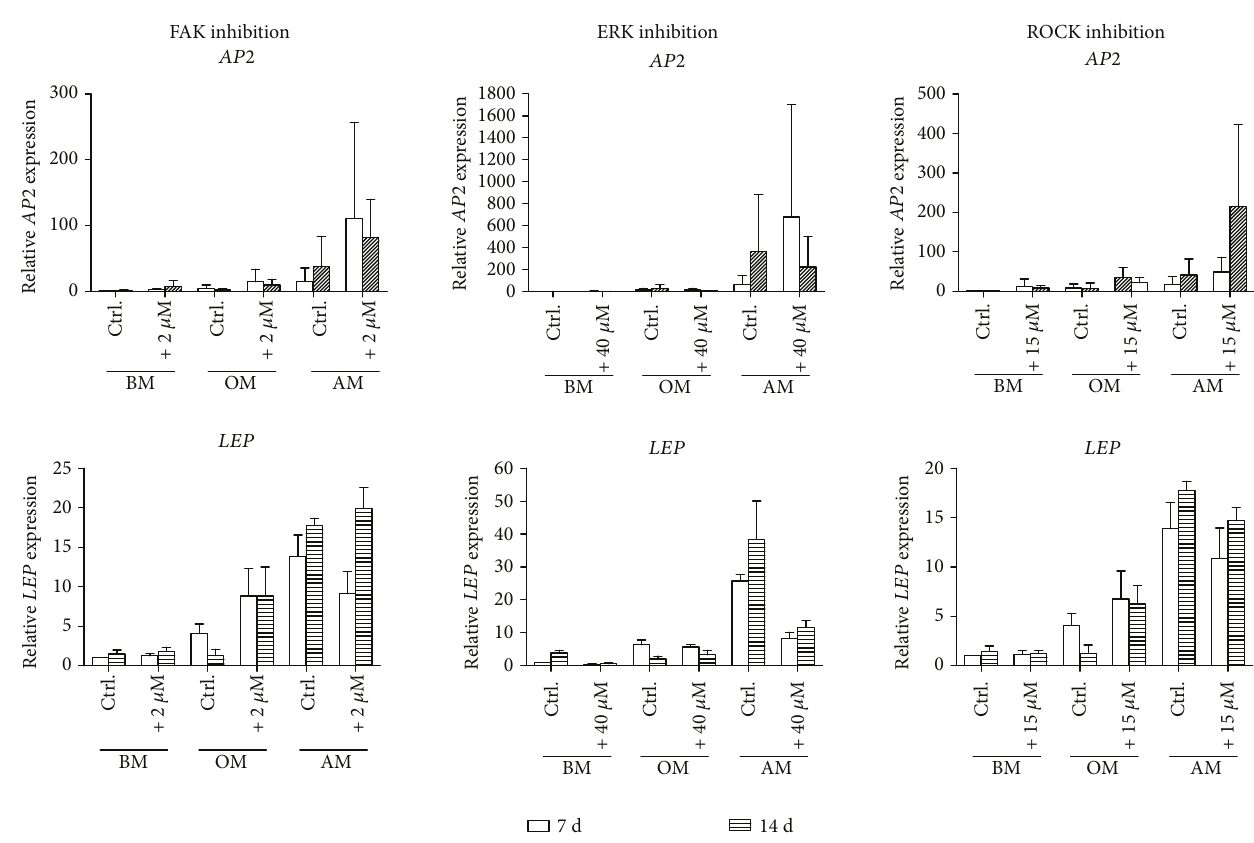
Figure 4: Expression of adipogenic marker genes AP2 and LEP in hASCs treated with FAK, ERK, and ROCK inhibitors. The hASCs were cultured in BM, OM, or AM supplemented with 2 μ M FAK, 40 μ M ERK, or 15 μ M ROCK inhibitors in addition to medium controls. AP2 and LEP expressions were analyzed with qRT-PCR. The expression of AP2 and LEP are normalized with the expression of the housekeeping gene RPLP0 , and the results are presented relative to the 7 d BM sample. FAK and ROCK: N = 5 (independent experiments, 5 donors), ERK: N = 3 (independent experiments, 3 donors). BM: basic medium; OM: osteogenic medium; AM: adipogenic